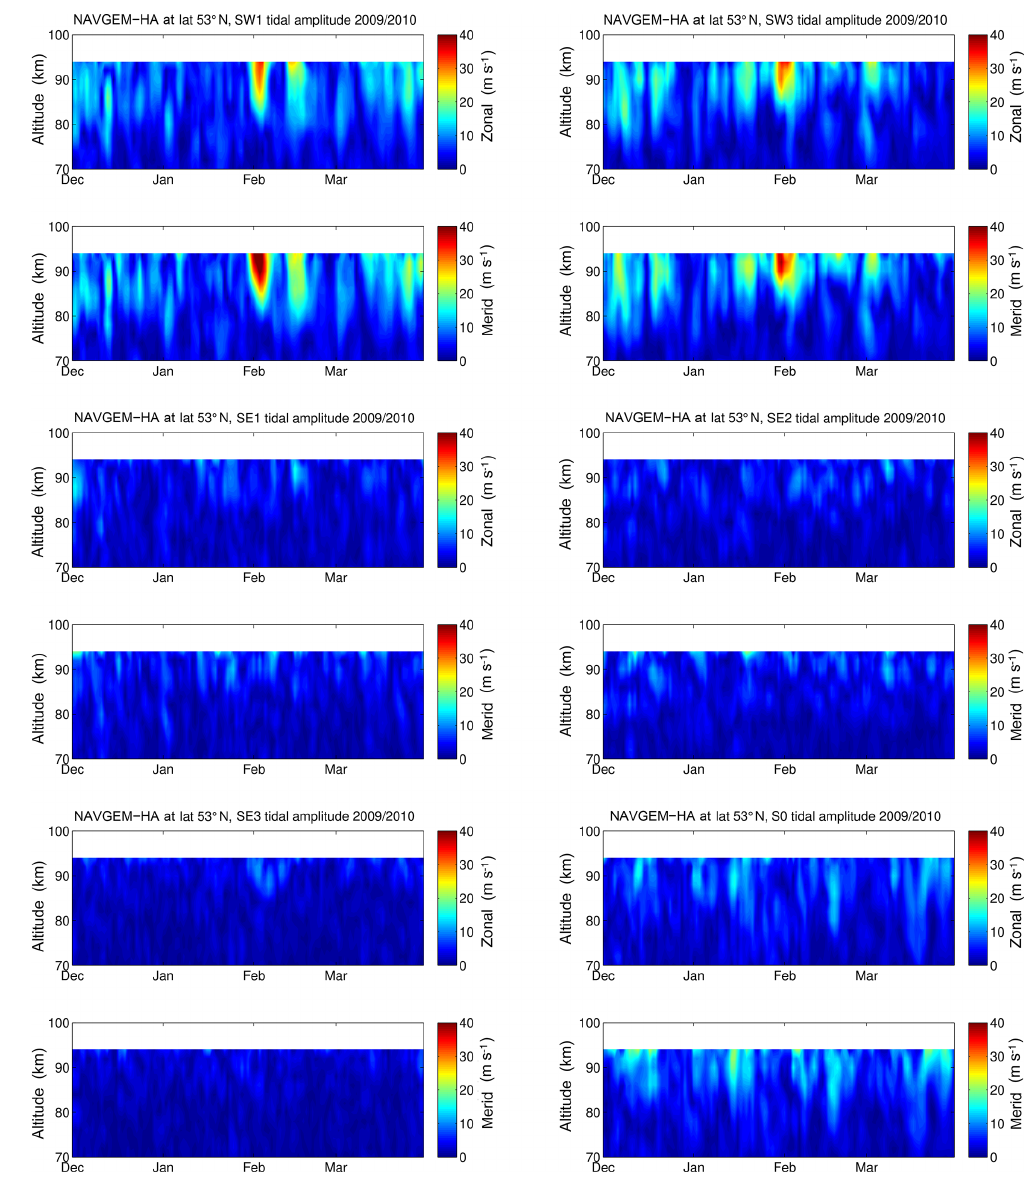
Figure B3. The same as Fig. 13 but above Juliusruh and for the winter of 2009/10.